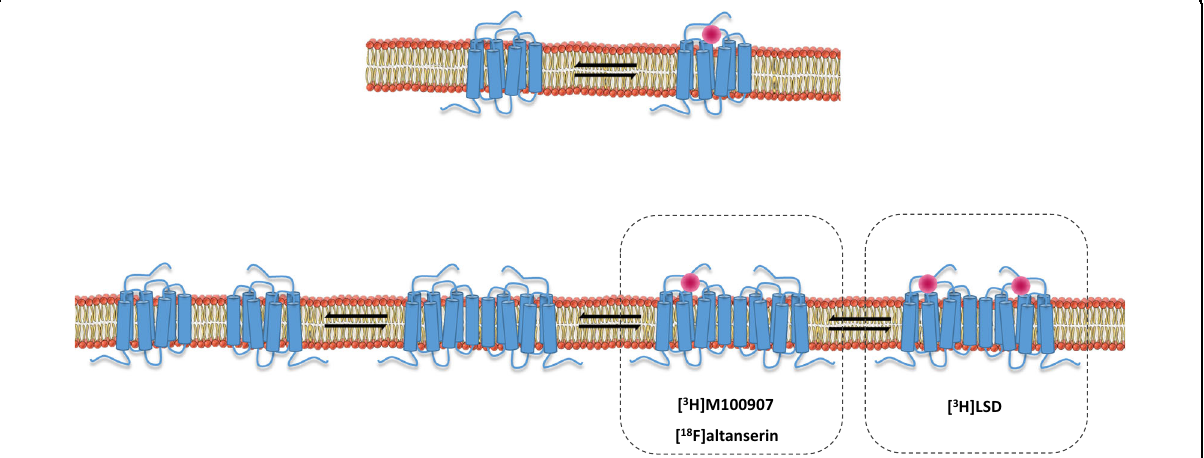
Fig. 4 Monomer and oligomer conformations of the 5-HT 2A R. The 5-HT 2A R is expressed as single monomers but also as receptor complexes constituted by two or more receptor units. The binding of a drug to one of the monomers of the complex could induce positive, negative or no cooperativity for the binding to other monomers with the complex. For example, the binding of the antagonist MDL100907 or the inverse agonist altanserin to one of the binding pockets of the homodimer introduces negative allosteric effects on the binding of the same drug to the second binding pocket 43 . This negative cooperativity would prevent the identi fi cation of the total number of binding sites. In contrast, the binding of hallucinogenic 5-HT 2A R agonist such as (±)DOB and LSD to receptor homodimers does not modify the estimation of the total number of binding sites 43 . Higher order 5-HT 2A R oligomeric and heteromeric complexes of 5-HT 2A Rs with other GPCRs are also feasible 24,42